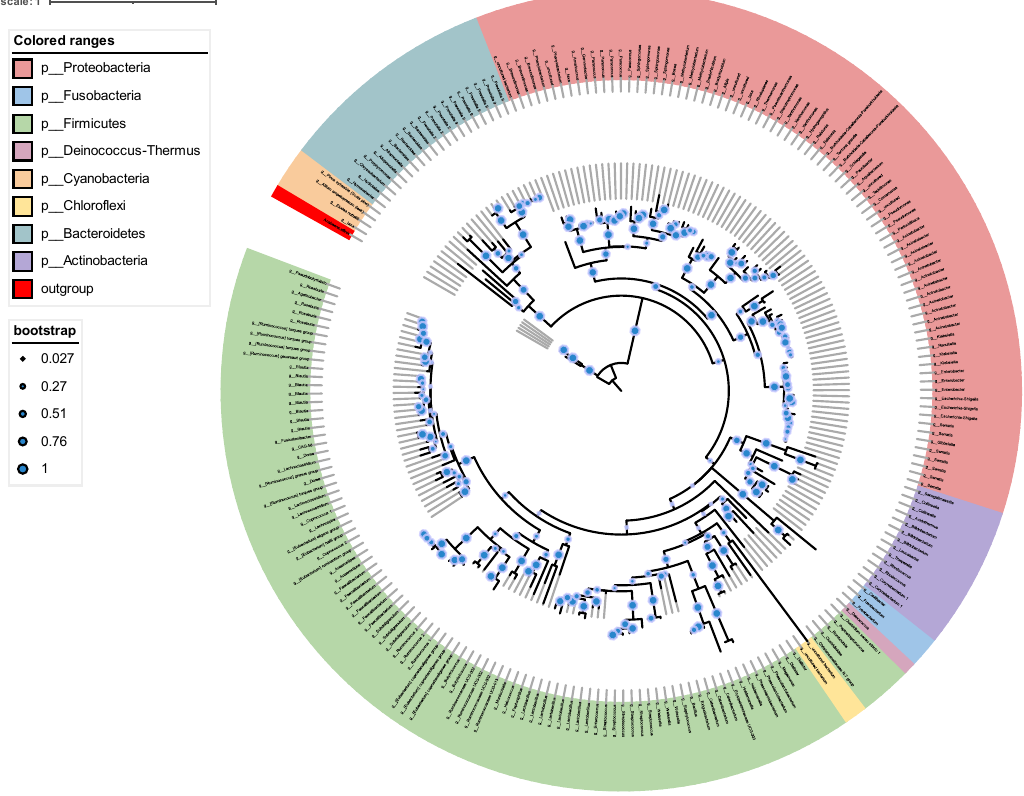
Figure 5. Phylogenetic tree showing the placement of 222 OTUs based on 16S rDNA sequence. The phylogenetic tree was produced by maximum likelihood methods with 1000 bootstrap replicates.